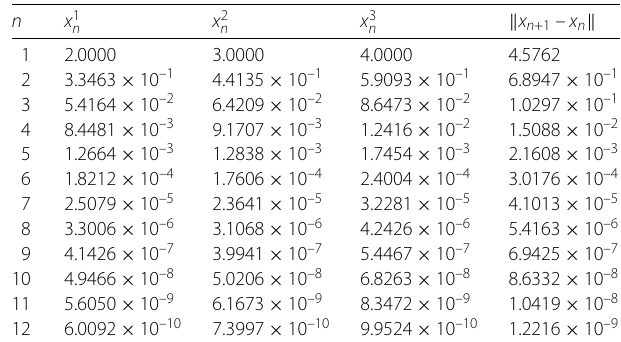
Table 1 Values of the components of x n and (cid:11) x n +1 – x n (cid:11) n x 1